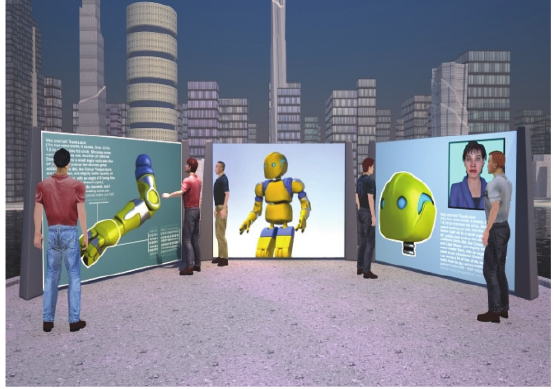
Figure 4. Kiosk in the virtual world of the ecosystem.